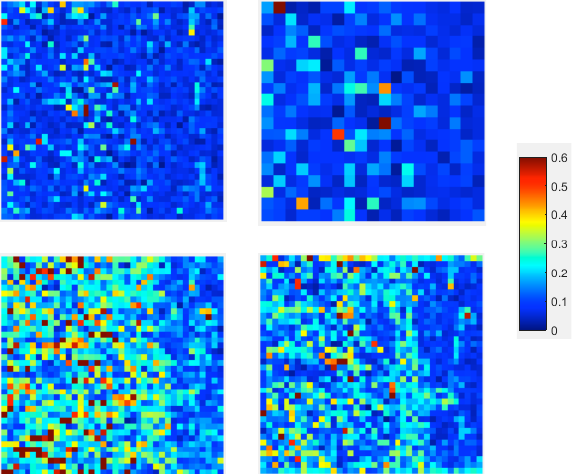
Figure 9. RMSE of the difference abundance estimations on HySpex image shown in Figure 8 for cases DESIS_GS30 (top-